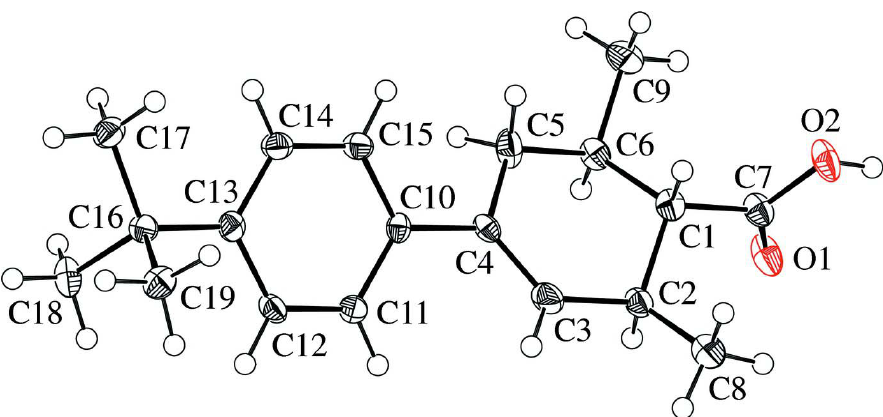
Figure 1 The molecular structure and atom numbering scheme, with displacement ellipsoids drawn at the 50% probablilty